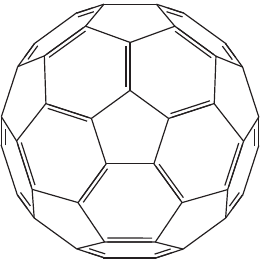
Figure 7. An allotropic form of carbon, the molecule (Buckminster-)fullerene, C 60 , consisting of twelve pentagons and twenty hexagons shaped into three-dimensional